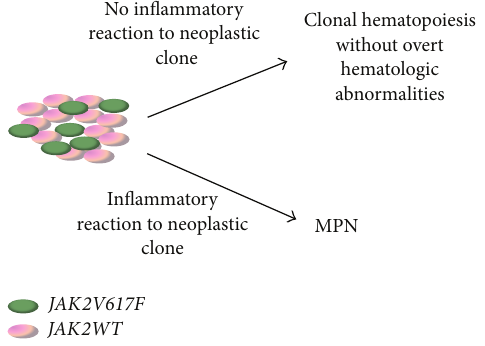
Figure 1: Putative role of inflammation in shaping MPN disease